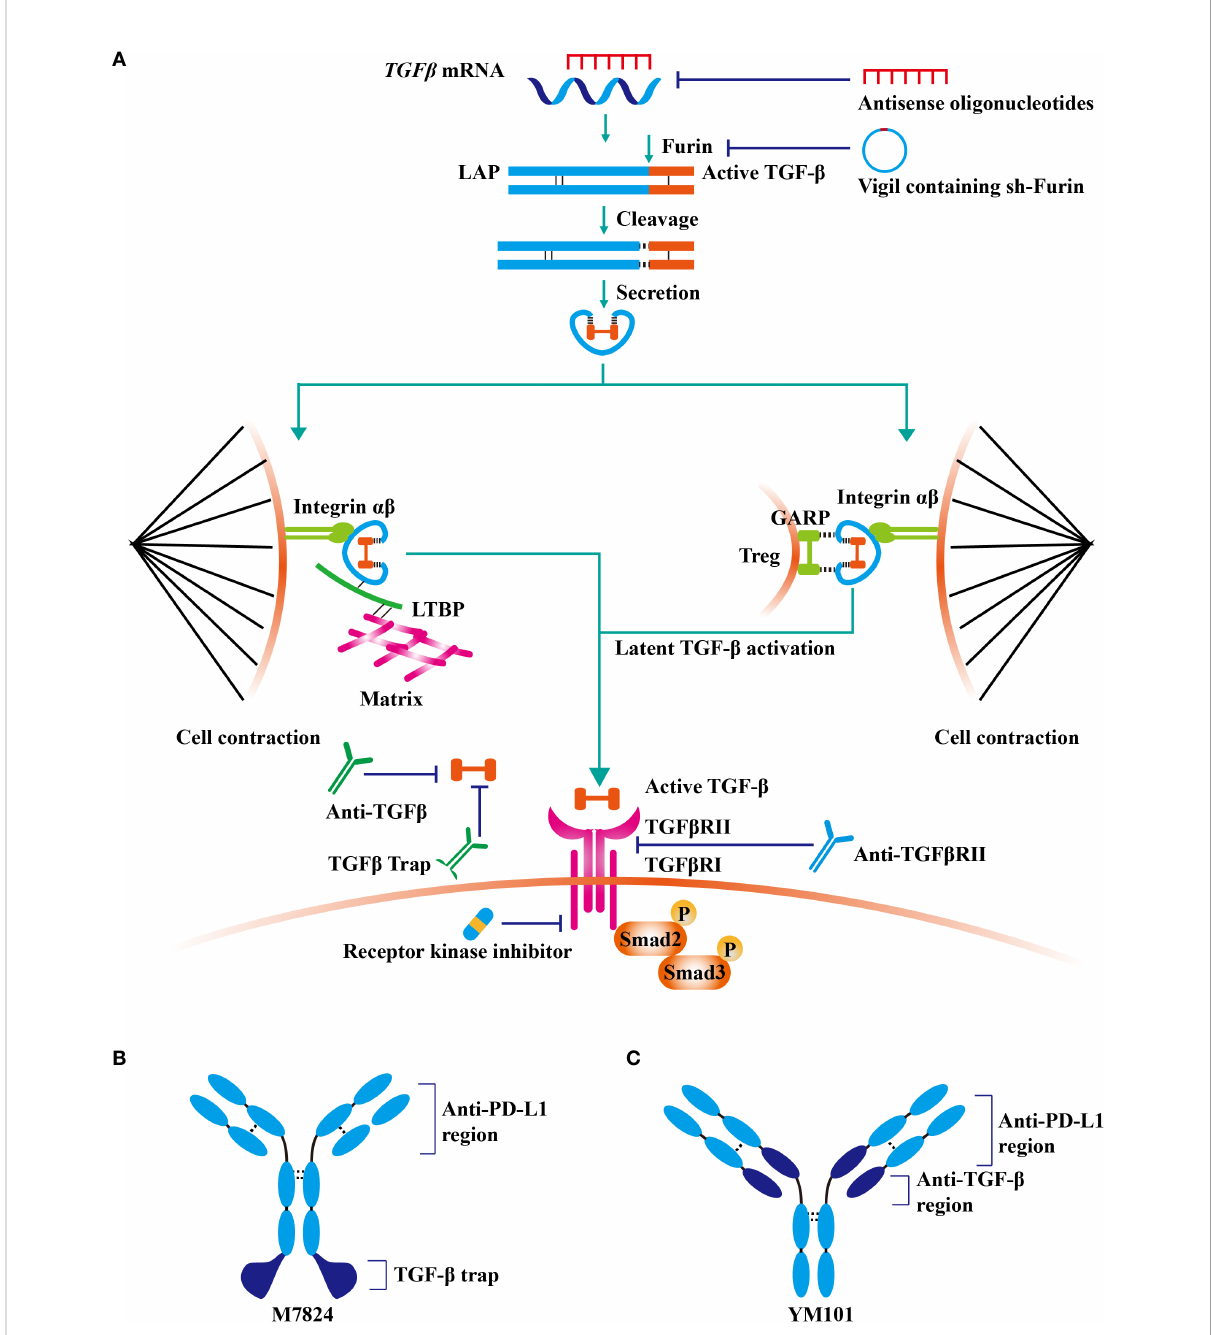
FIGURE 2 TGF- b signaling-targeted antitumor agents. At present, TGF- b signaling has been a hot therapeutic target for cancer investigators, and enormous efforts have been expended on the development of TGF- b -targeted agents. (A) TGF- b blockade strategies, including monoclonal antibodies (containing bispeci fi c antibodies), ligand traps (containing bi-functional proteins), receptor kinase inhibitors, vaccines, and antisense oligonucleotides, are under clinical evaluation. (B) The structure of fusion protein M7824. (C) The structure of bispeci fi c antibody